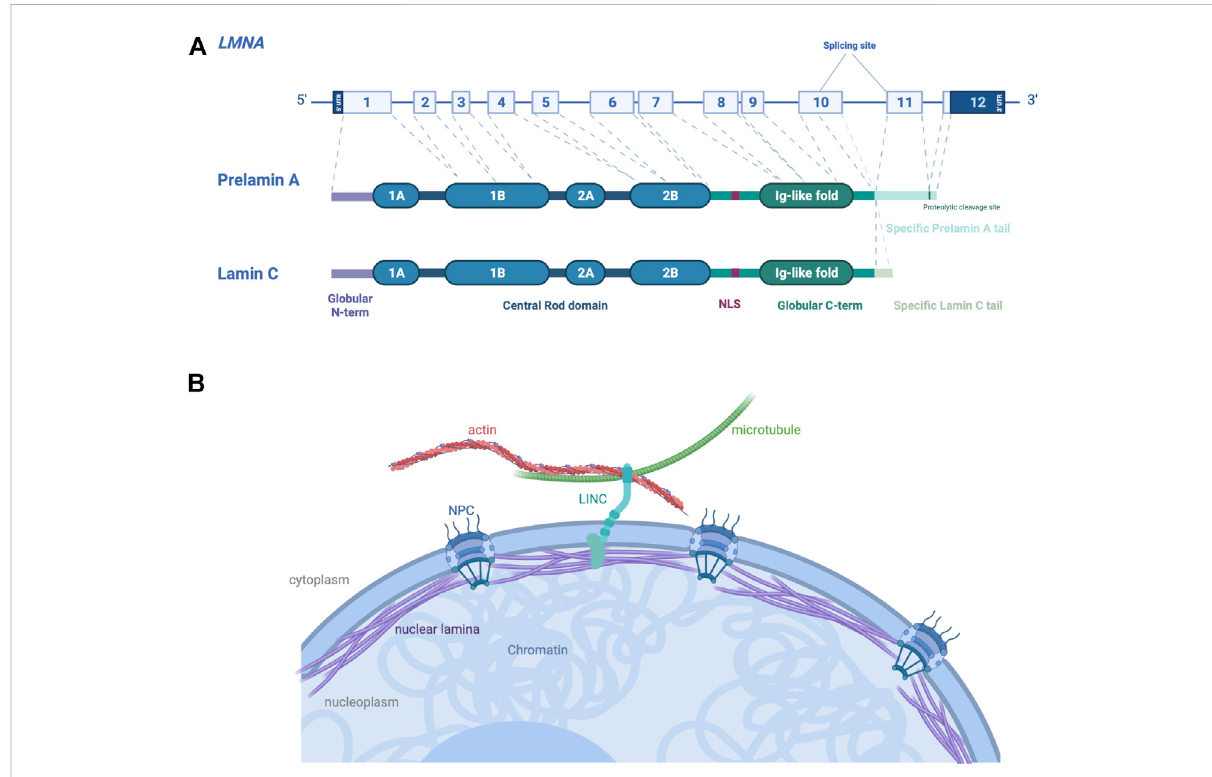
FIGURE 2 Schematic representation of A-type A/C and their localization in cells. (A) LMNA gene encodes the A-type lamins, with prelamin A and lamin C generated by alternative RNA splicing being the major somatic cell isoforms. (B) Schematic view of A-type lamins, proteins of the nuclear lamina on the inner aspect of the inner nuclear membrane, cause autosomal dominant EDMD. The interactions between A-type lamins with SUN and KASH proteins form the LINC complex, connecting the nucleus to cytoskeleton in the cytoplasm of somatic cells. Created with